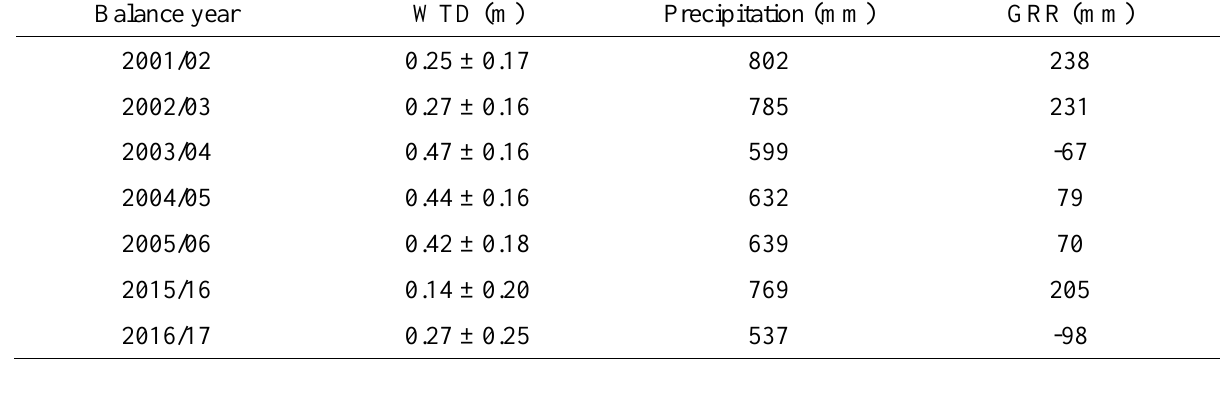
Table 2. Mean water table depth (WTD), precipitation rates and groundwater recharge rates (GRR) of the study fields (n = 50). The balance year is from 1 May to 30 April of the following year. The WTD is given as mean